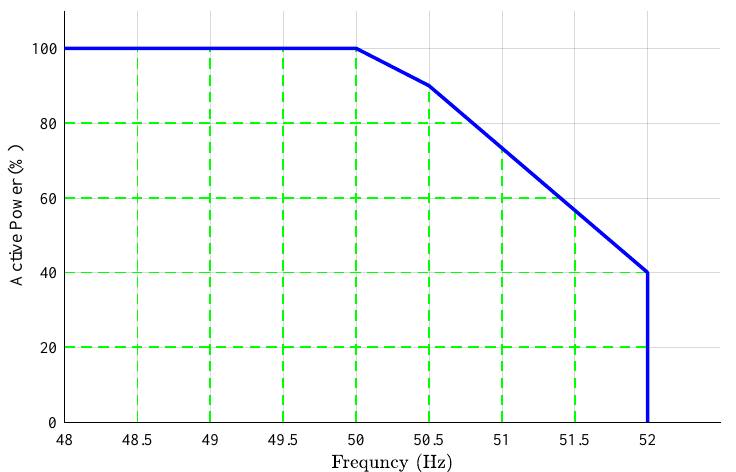
Figure 10. Typical active power limit response as a function of frequency variations (50 Hz